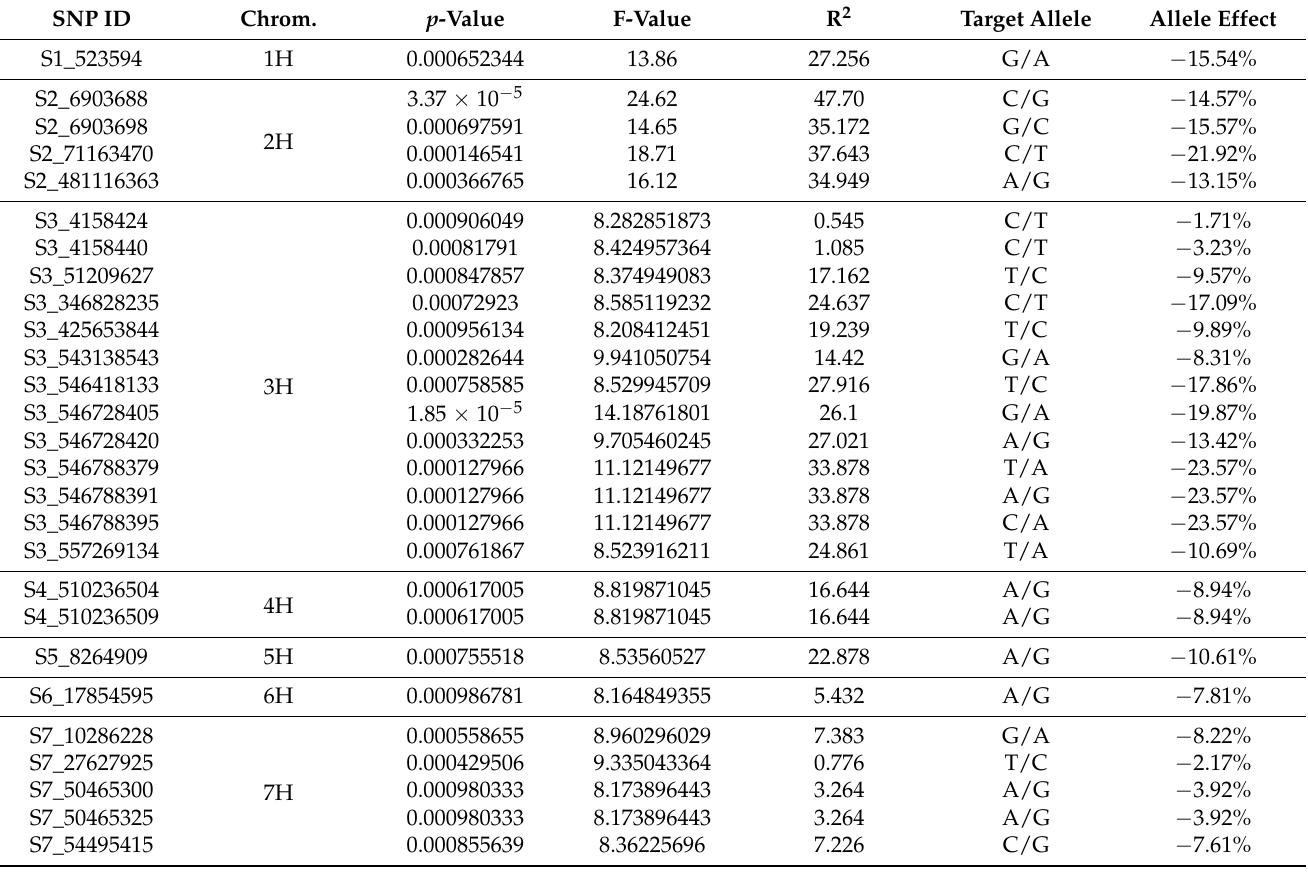
Table 2. Single marker analysis (SMA) for loose smut resistance in the 60 barely genotypes comprising the Egyptian spring barley